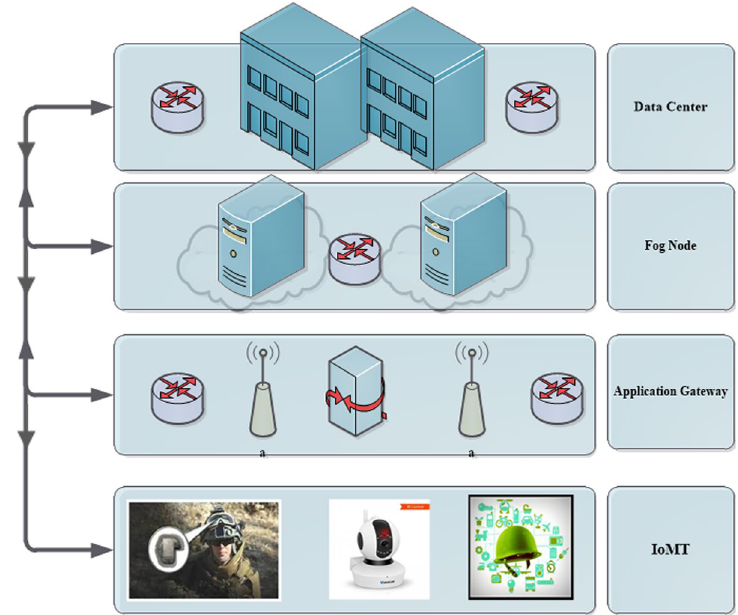
Fig. 1 A military-based IoT- Fog application